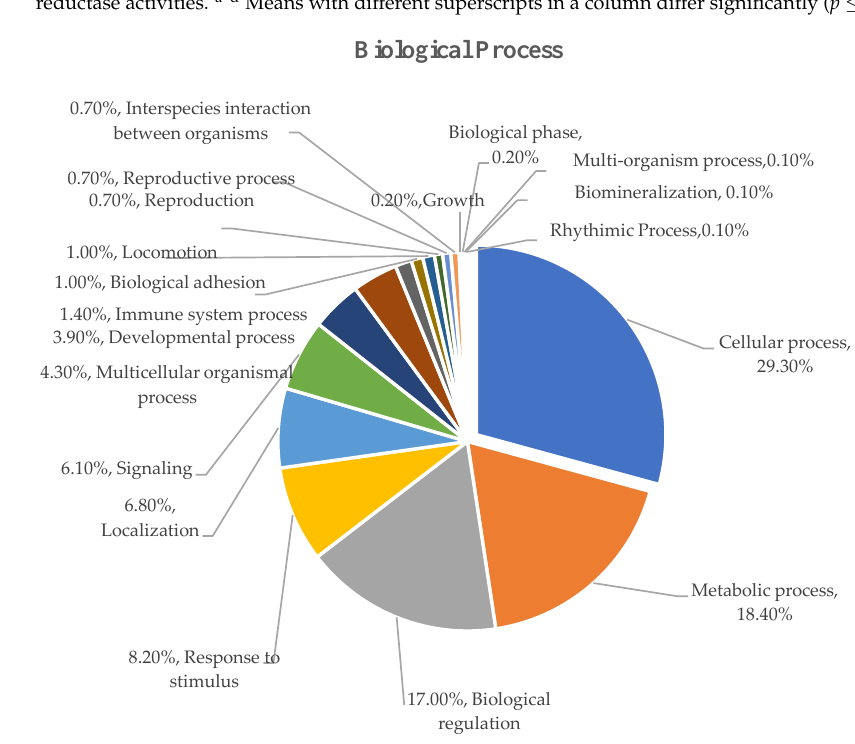
Figure 2. Functional classification of biological processes of serum protein samples from dairy cows during a 14 day period.